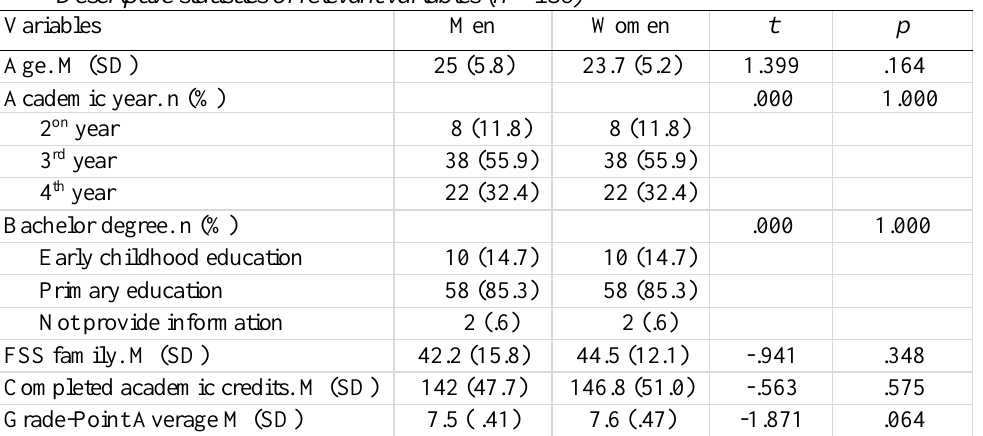
Descriptive statistics of relevant variables (n =